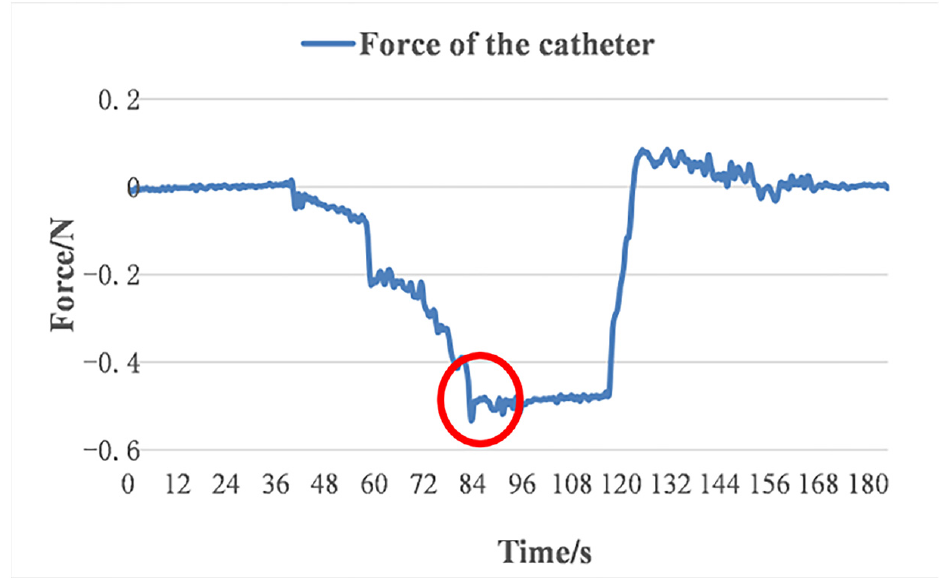
Figure 19. The force of the catheter under condition 2.